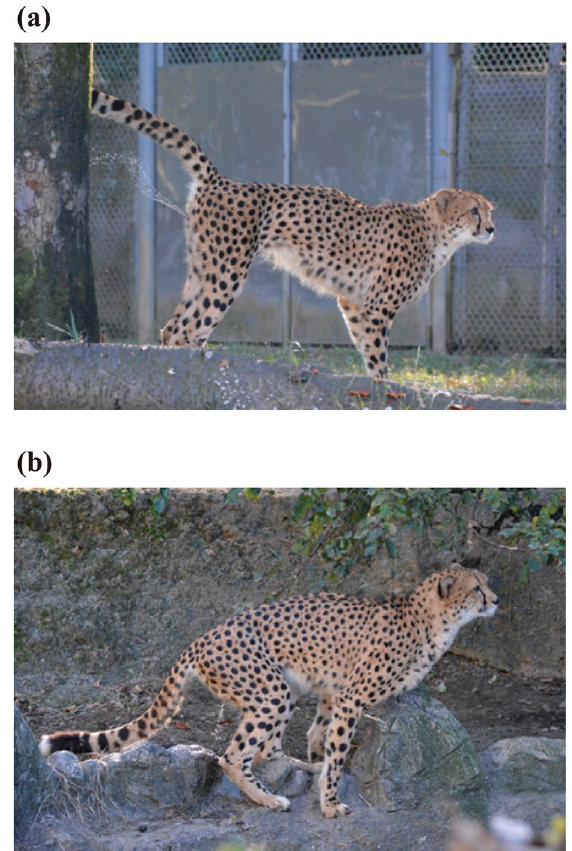
Figure 1. Behaviors of captive cheetahs that were thought to be scent-marking: ( a ) excretory posture at the time of urine spraying and ( b ) excretory posture at the time of